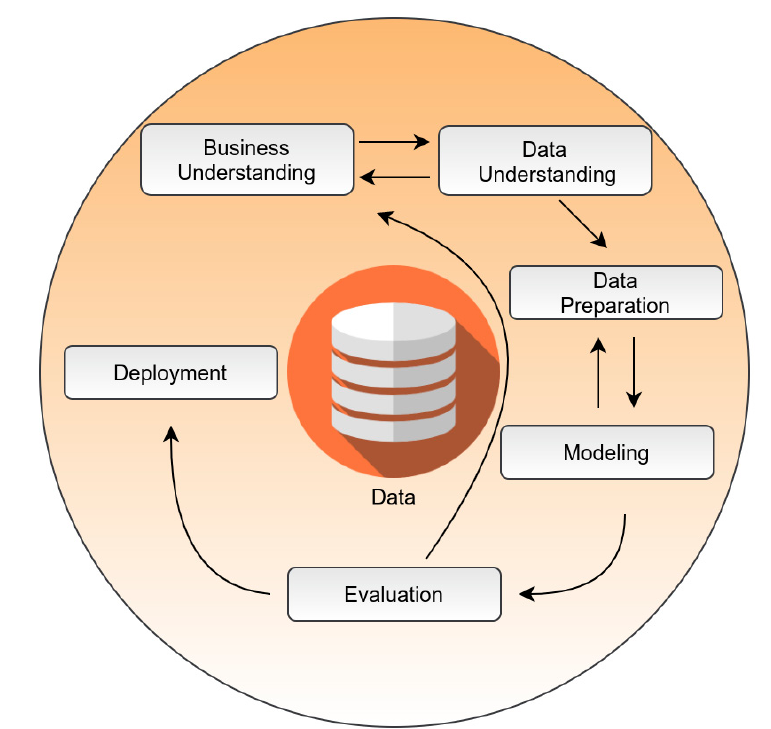
Figure 5. The current cross-industry standard process for data mining (CRISP-DM). It illustrates the six phases of a data mining project, which do not follow a strict sequence. The arrows indicate only the most important and frequent relationships between phases; however, each transition depends on the outcome of each phase, defining the task to be performed next.